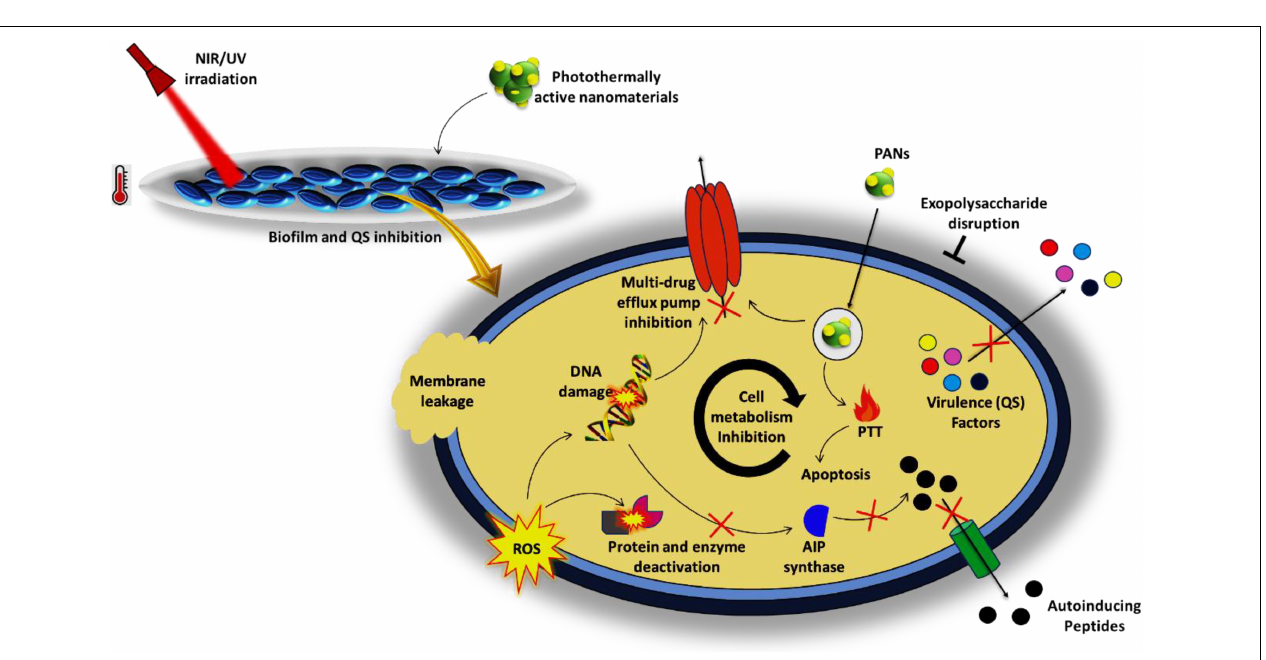
FIGURE 4 | Mechanism for photothermal and Photocatalytic Eradication of MRSA Biofilms and Osseointegration Using Oxide Perovskite-Based P–N Heterojunction under Enhanced Near–Infrared (p-type CTO, perovskite-type calcium titanate; p-type RP, perovskite-type red phosphorous; ALP, alkaline phosphatase; OCN, Osteocalcin; OPN, Osteopontin; OSN, Osterix; RunX-2, runt-related transcription factor 2; COL I, Collagen type I; MSCs, mesenchymal stem cells; CB, conduction band; VB, valence band). Adapted from Mao et al. (2021). Copyright (2021) Wiley-VCH.